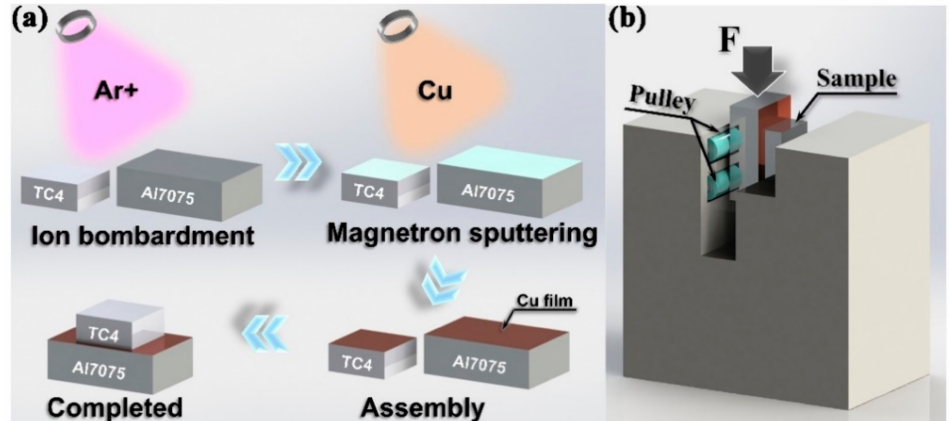
Figure 1. Schematic diagram of the TC4/Al7075 contact reactive brazing process ( a ) and shear test experiment ( b ).